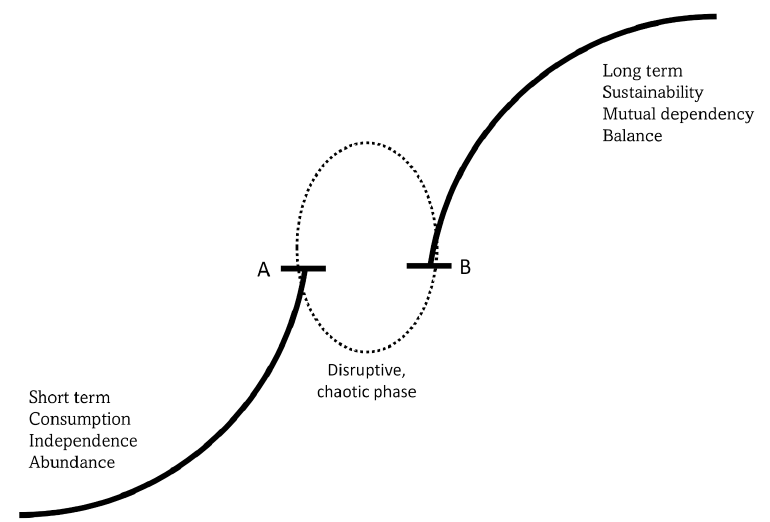
Figure 3. Standing at the brink of a new time (B), while currently being in a period of disruption (A) (source: